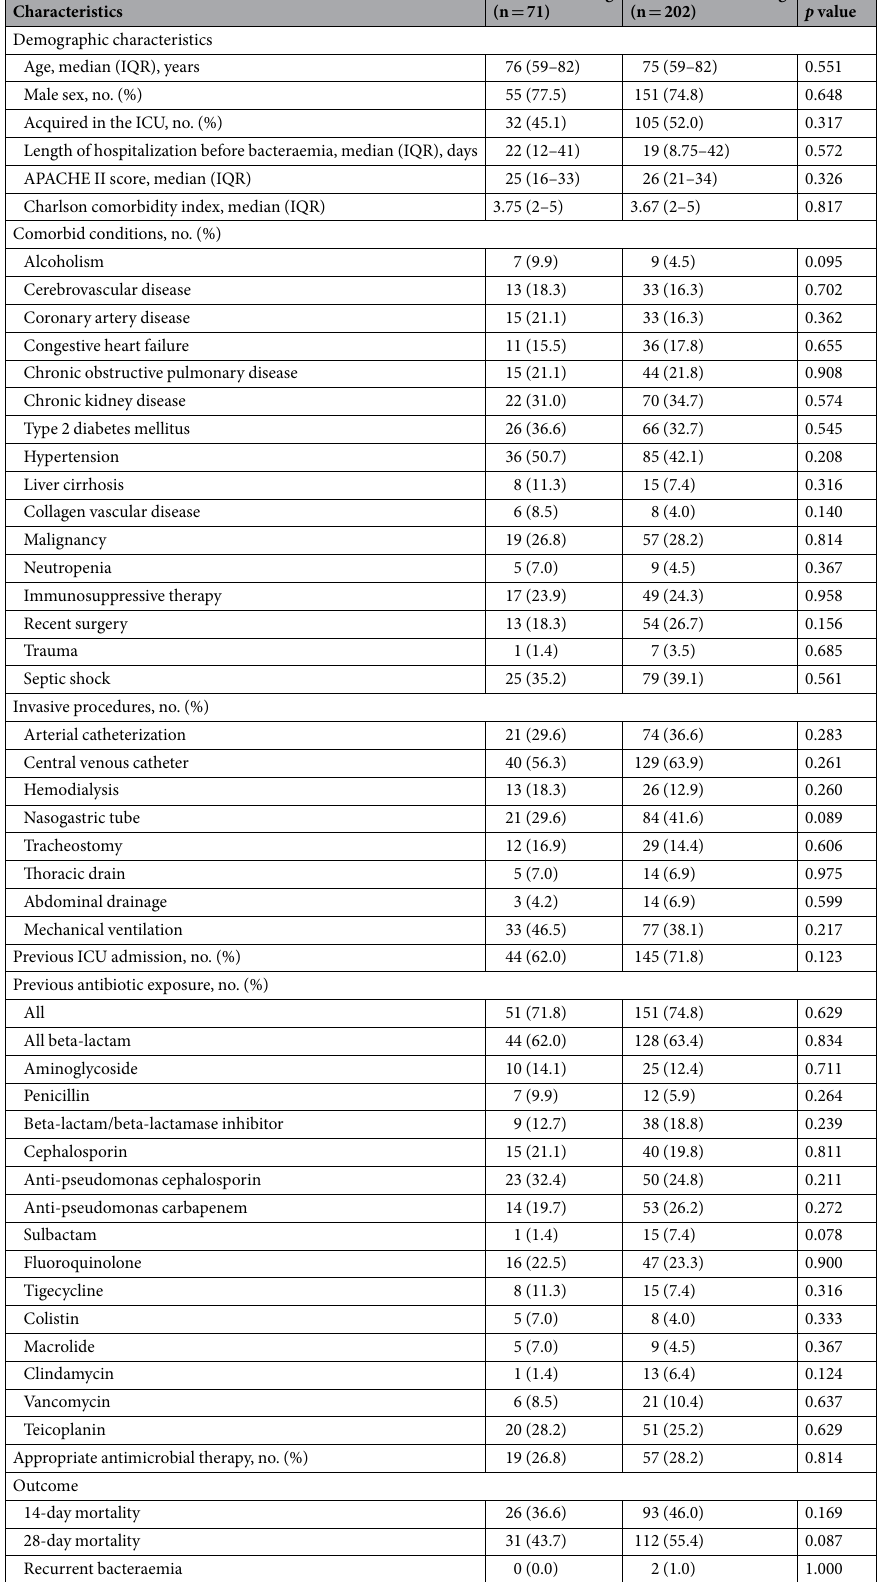
Table 1. Demographic and clinical characteristics of patients with bacteraemic pneumonia caused by biofilm- forming and non-biofilm-forming Acinetobacter baumannii . * APACHE II = Acute Physiology and Chronic Health Evaluation II, ICU = intensive care unit, IQR = interquartile